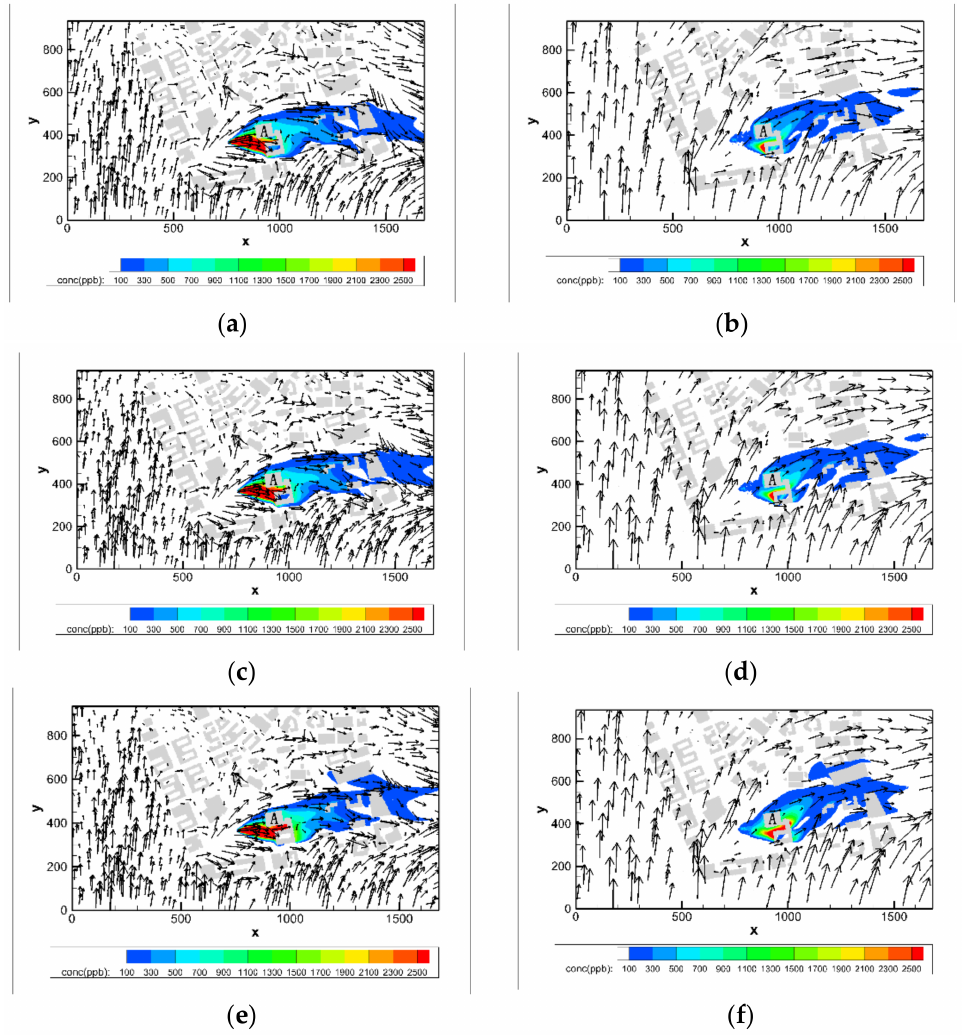
Figure 8. Simulated concentrations (ppb) and wind vector fields of the LST at 20:08, 9 August LST. The arrow shows the wind: ( a , c , e ) at z = 1.5 m; ( b , d , f ) at z = 21.5 m; ( a , b ) unstable condition; ( c , d ) neutral condition; ( e , f ) stable